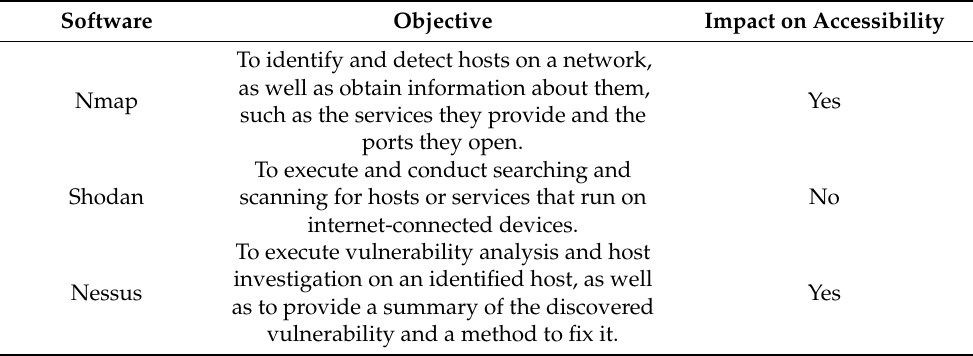
Table 2. Scanning tools for industrial control